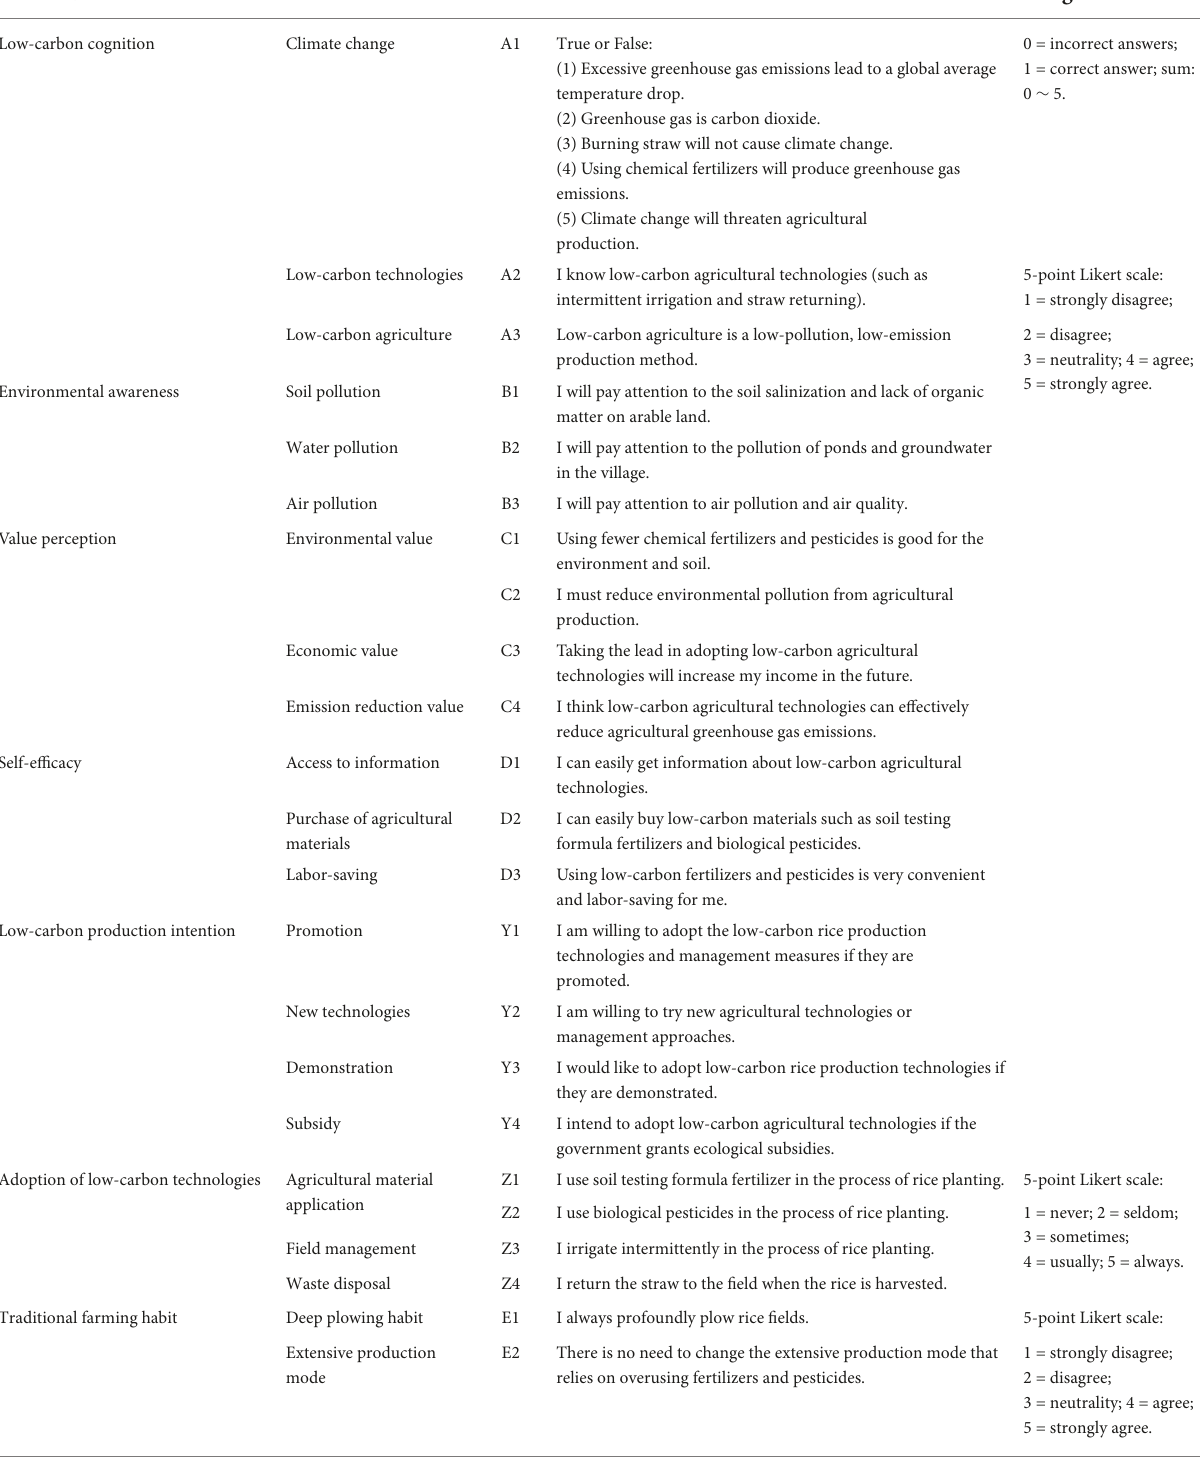
TABLE 1 Scales of rice farmers’ adoption of low-carbon technologies and relevant variables. Variable/dimension Num. Item Range Low-carbon